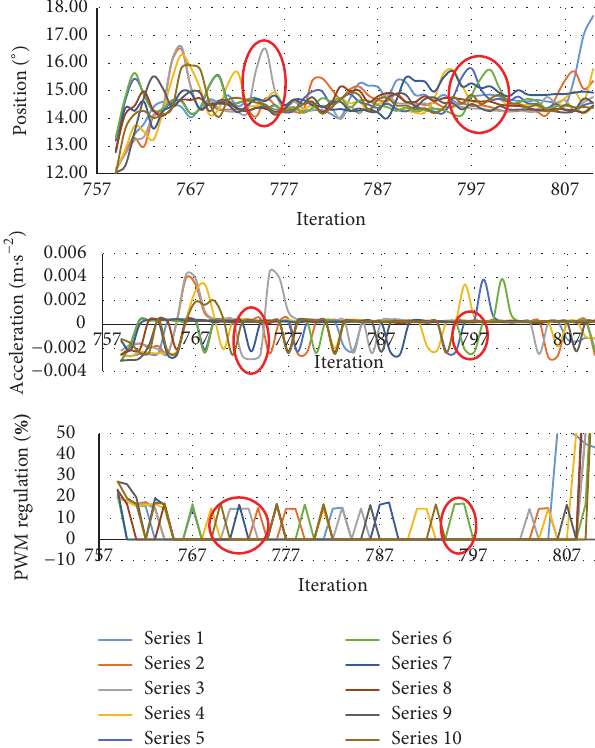
Figure 10: Analysis of graphs of the experimental measurement number